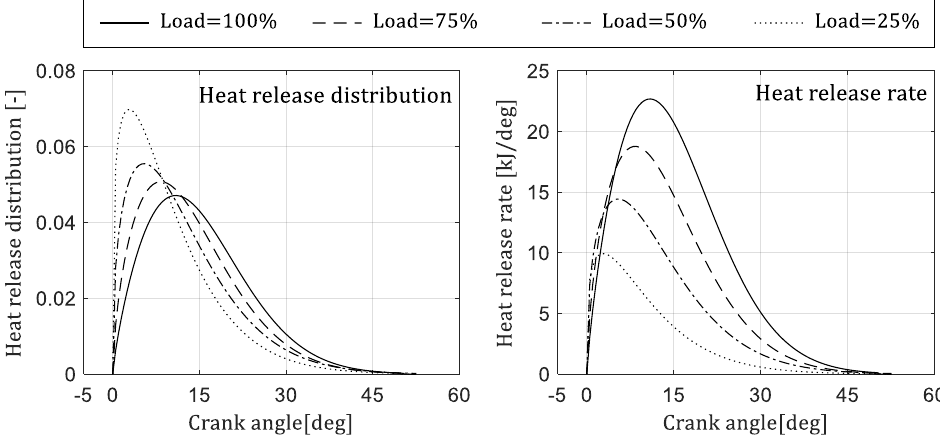
Figure 7. The heat release characteristics of the engine in gas fuel mode with WA model.